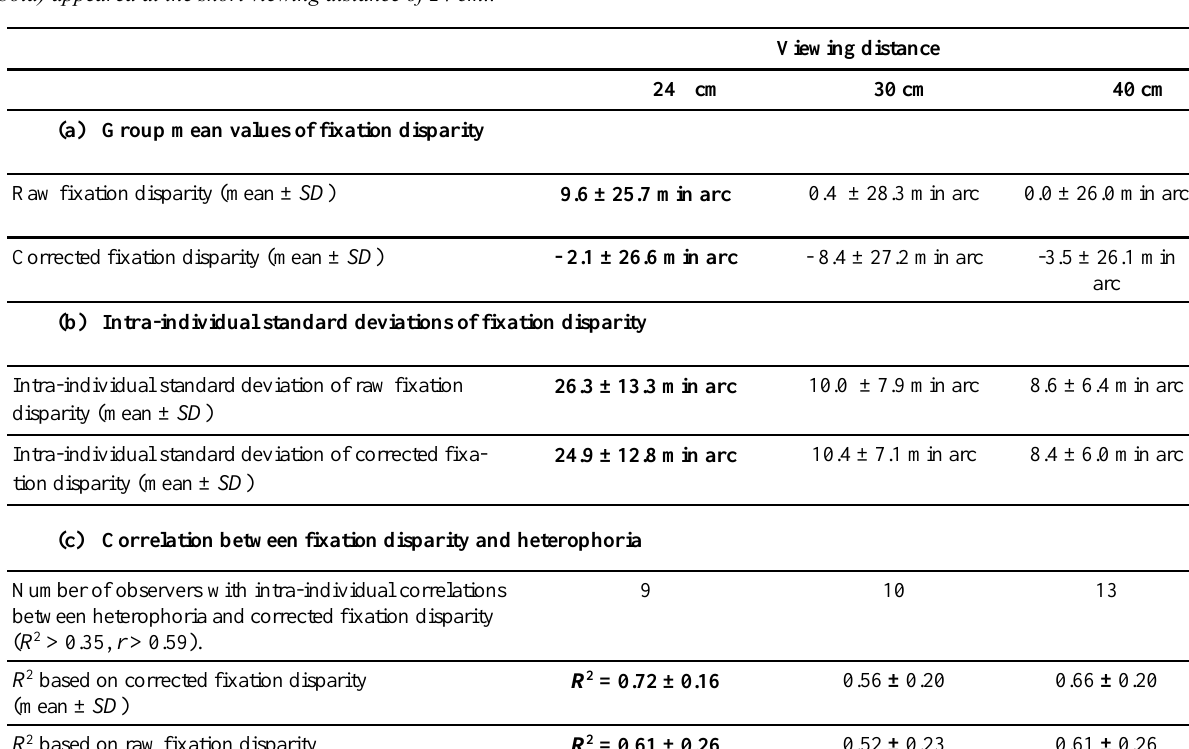
Table 1. Raw versus corrected fixation disparity: statistical indicators based on the sample of 20 subjects. Significant effects (in bold) appeared at the short viewing distance of 24